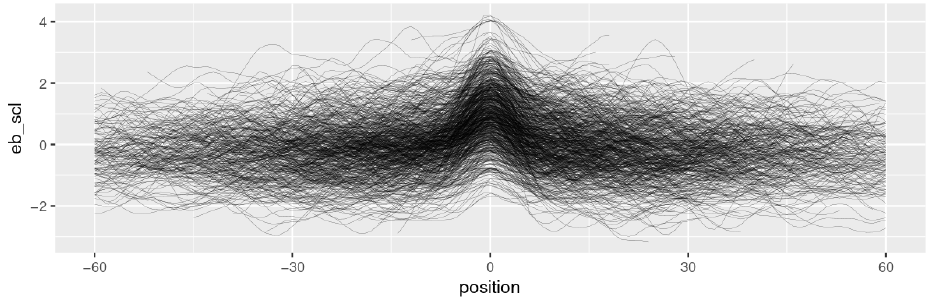
Figure 2. Time series for eyebrow movement around the peak of a segment (speaker sample). The values are scaled per